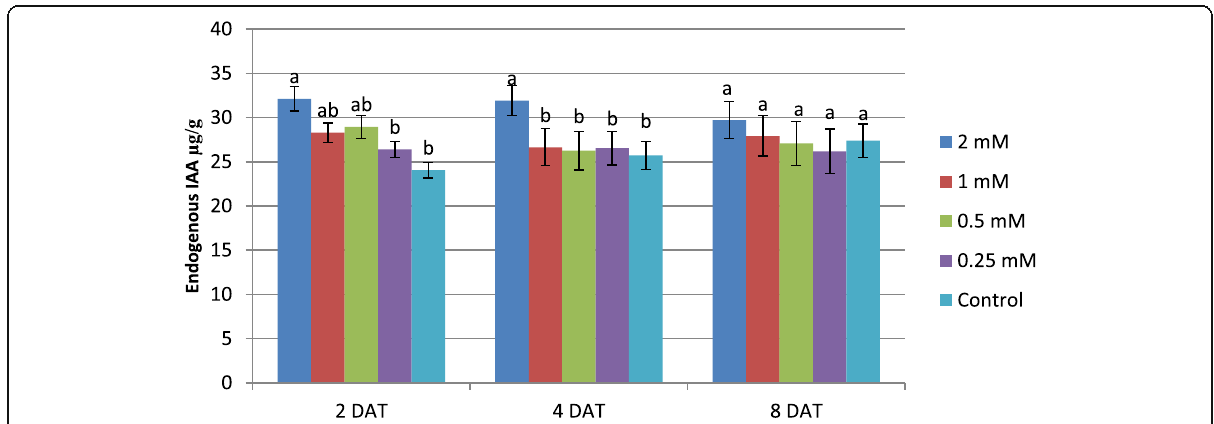
Fig. 2 Changes in endogenous IAA over time in maize plants in response to their exogenous application at different